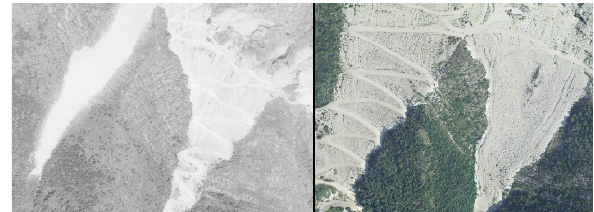
Figure 2 . 1978 and 2012 BW high resolution aerial images of Mount Bettogli debris disposals.